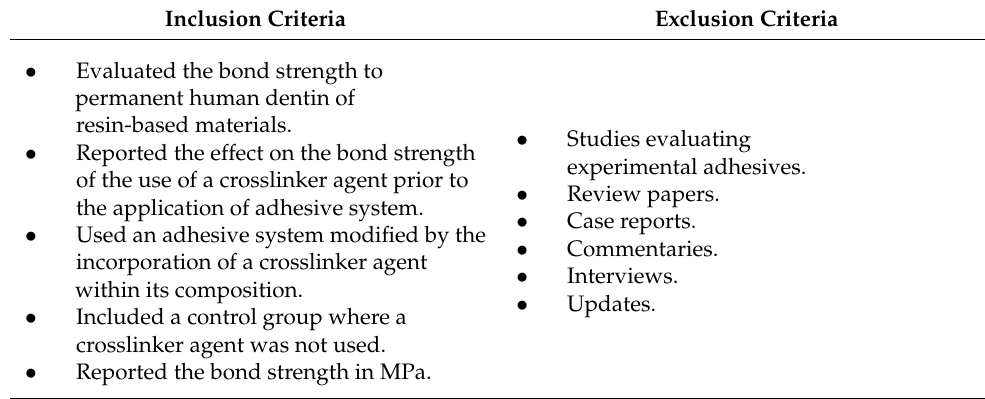
Table 2. Inclusion and exclusion